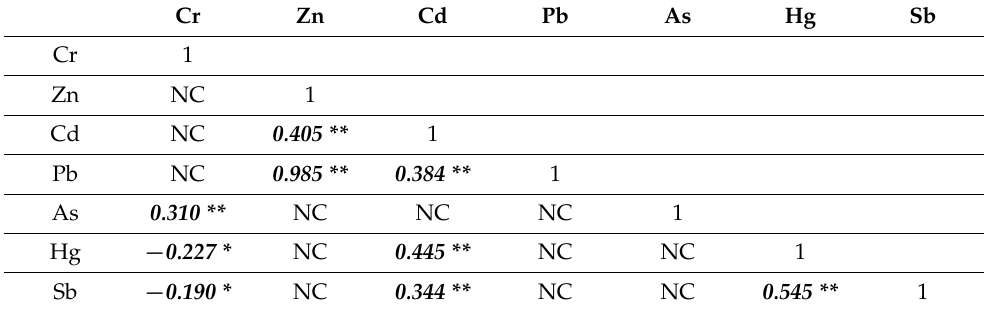
Table 2. Correlation coefficients between the PTEs concentrations from the six sampling sites. Cr Zn Cd